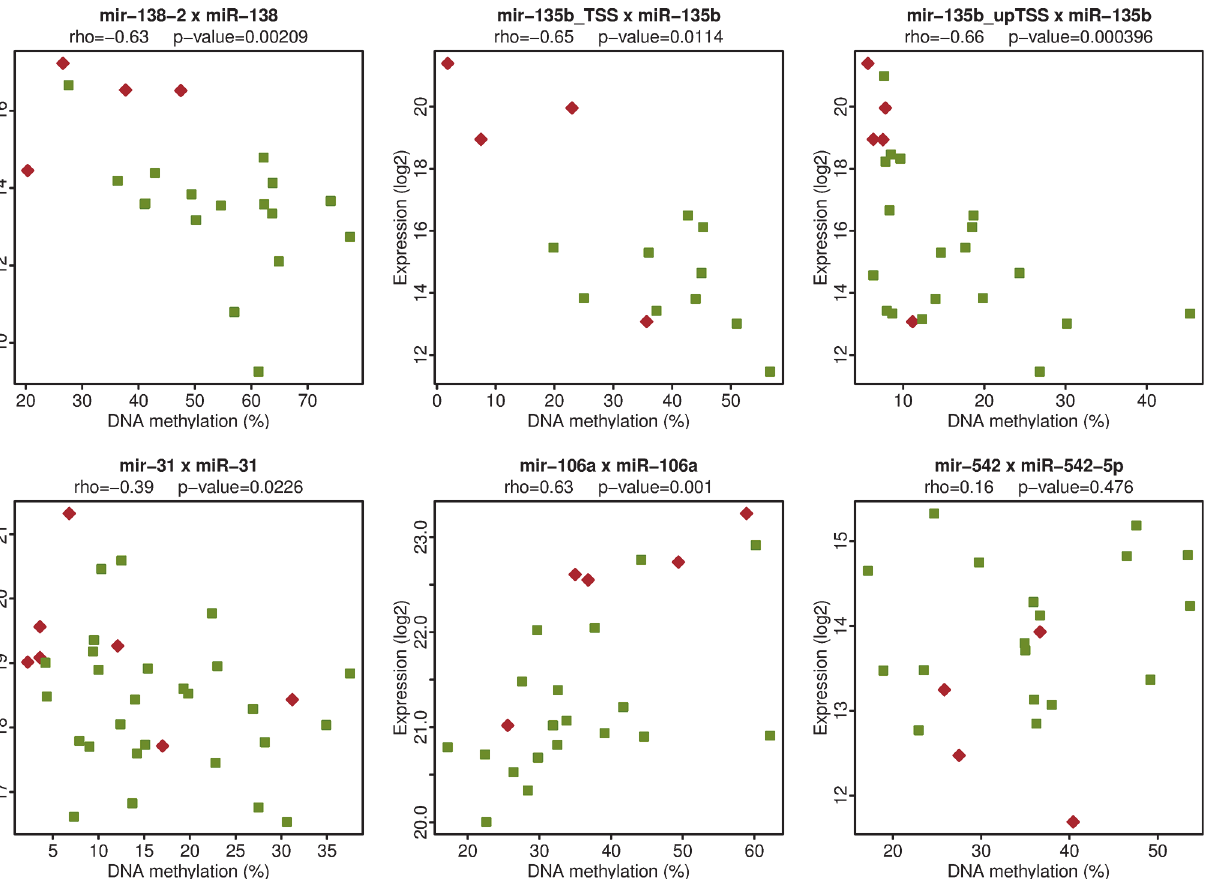
Fig 5. Linkage between miRNA expression and DNA methylation. The x-axis shows the mean DNA methylation (%) of the miRNA Sequenom MassARRAY amplicons. The y-axis shows the miRNA expression levels as determined by quantitative RT-PCR analysis. The names of miRNA genes analyzed by MassARRAY and the names of the respective mature miRNA products detected by quantitative RT-PCR are displayed at the top of each plot. The Spearman correlation coefficient rho and the p-value (two-sided) of the correlation are displayed on the second line at the top of each plot.